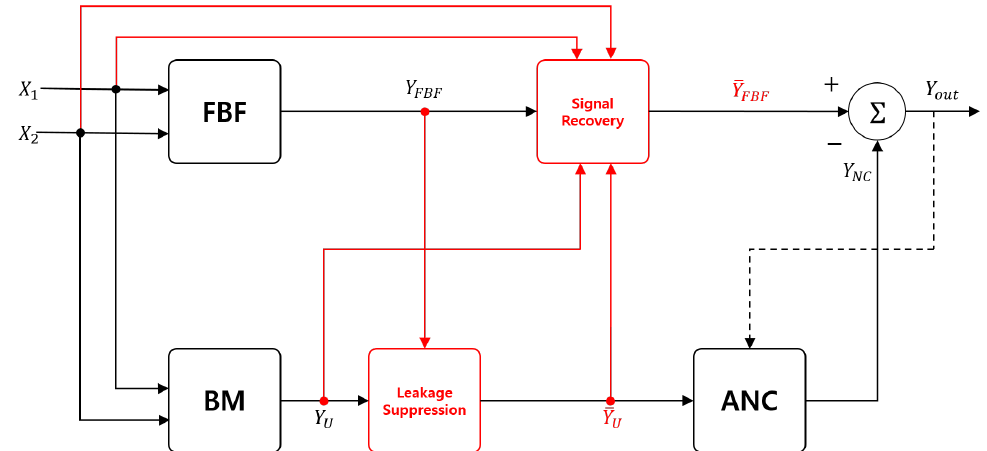
Figure 1. A block diagram of the conventional transfer function-generalized sidelobe canceller (TF-GSC) (black) and the proposed one with leakage suppression and signal recovery (black+red). FBF, fixed beamformer; BM, blocking matrix; ANC, adaptive noise